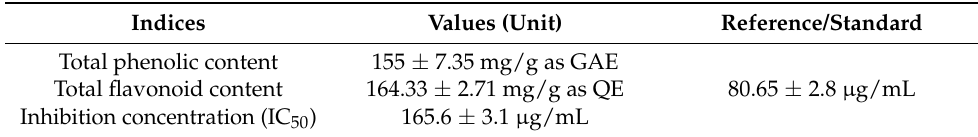
Table 1. Antioxidative status of